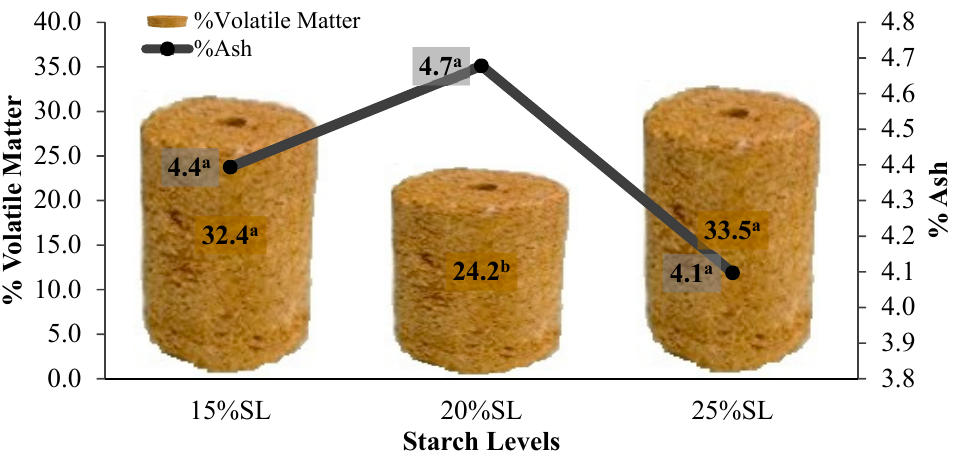
Figure 8 . Effect of starch levels on percentage volatile matter (%VM) and Ash (%) of the briquette. Means in the same bar having the same superscript are not significantly different ( p ≥ 0.05).